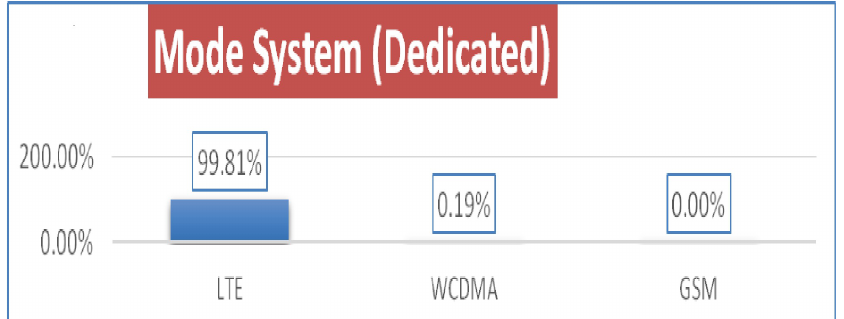
Figure 5. The allocation of the resources of the architecture for the reference network data